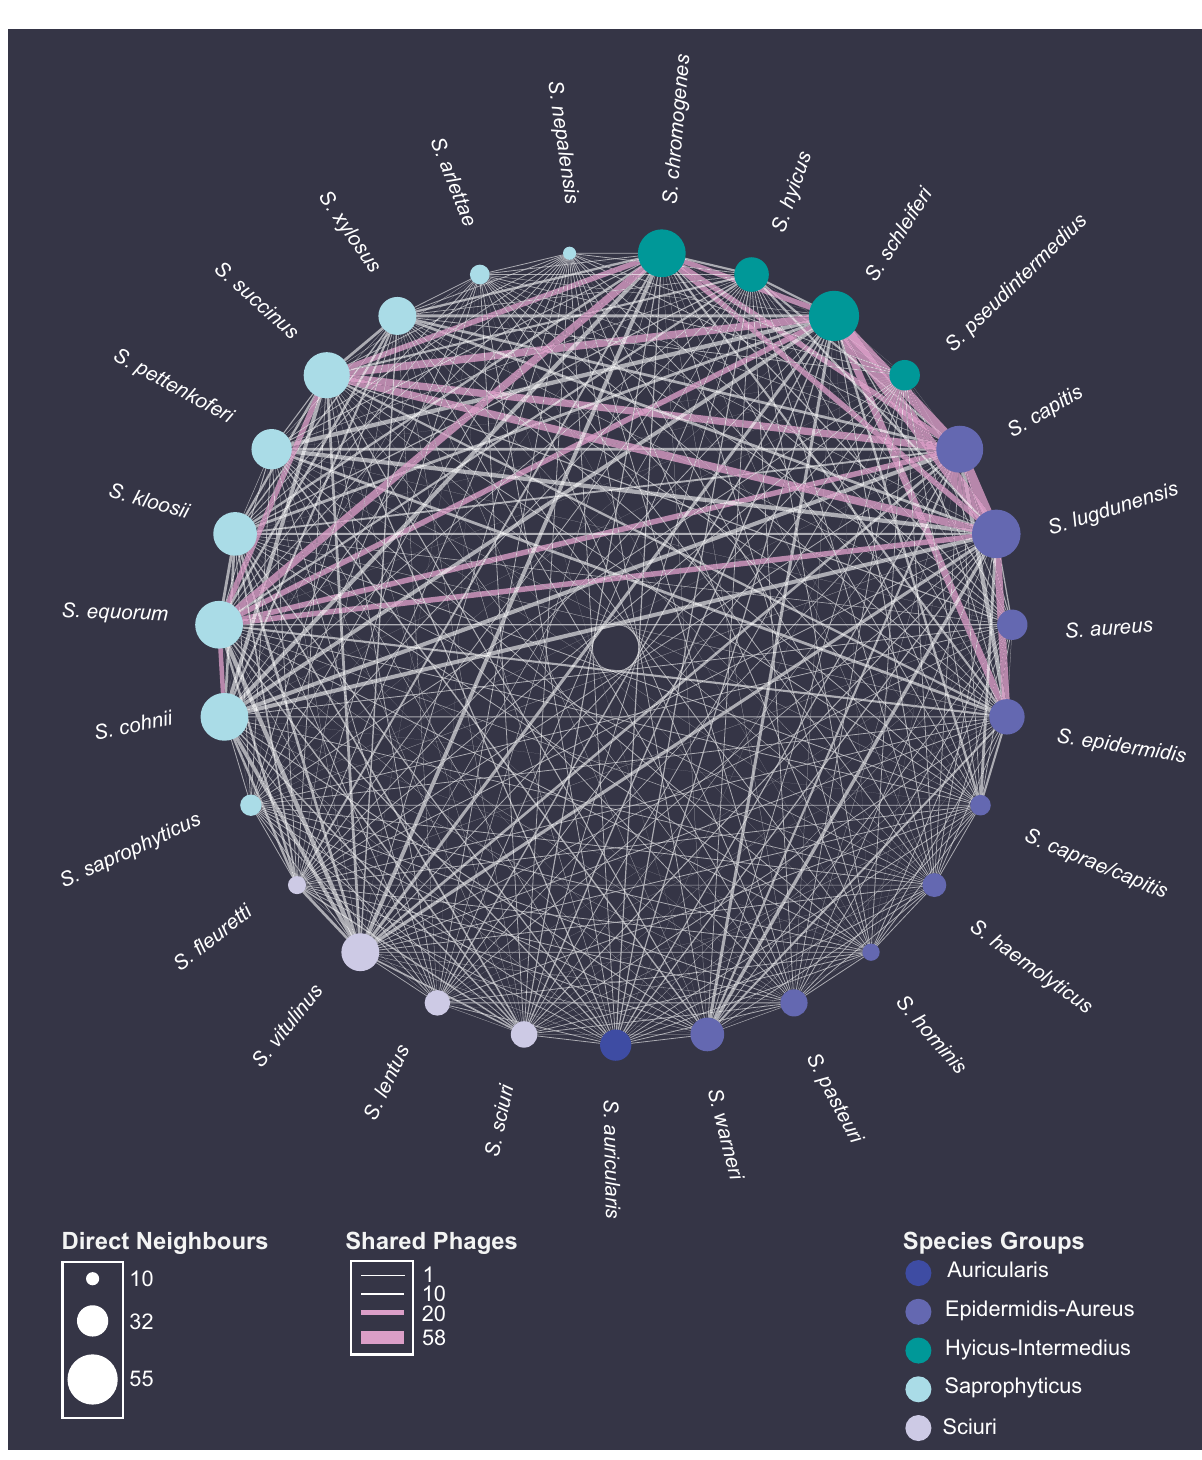
Fig. 4 Species network with phages as coupling links. Staphylococcal host species are represented as nodes and sorted after cluster af fi liation 13 . The area of each node directly correlates with the average number of strain neighbors a species is connected to. The number of shared phages between species is represented as weighted edges. If >20 phages are shared between two staphylococcal species, edges are colored in pink. Source data are provided as a Source Data fi